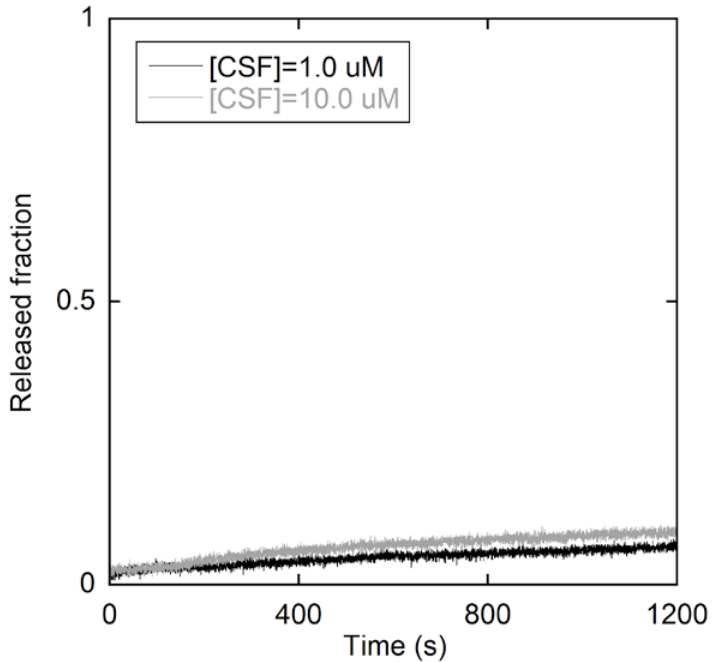
Figure 2. Kinetics of calcein release after addition of the type I’ β -turn peptide structure CSF114 to a LUV suspension. [Lipid] = 50 µM and [Peptide] = 1.0 µM and 10.0